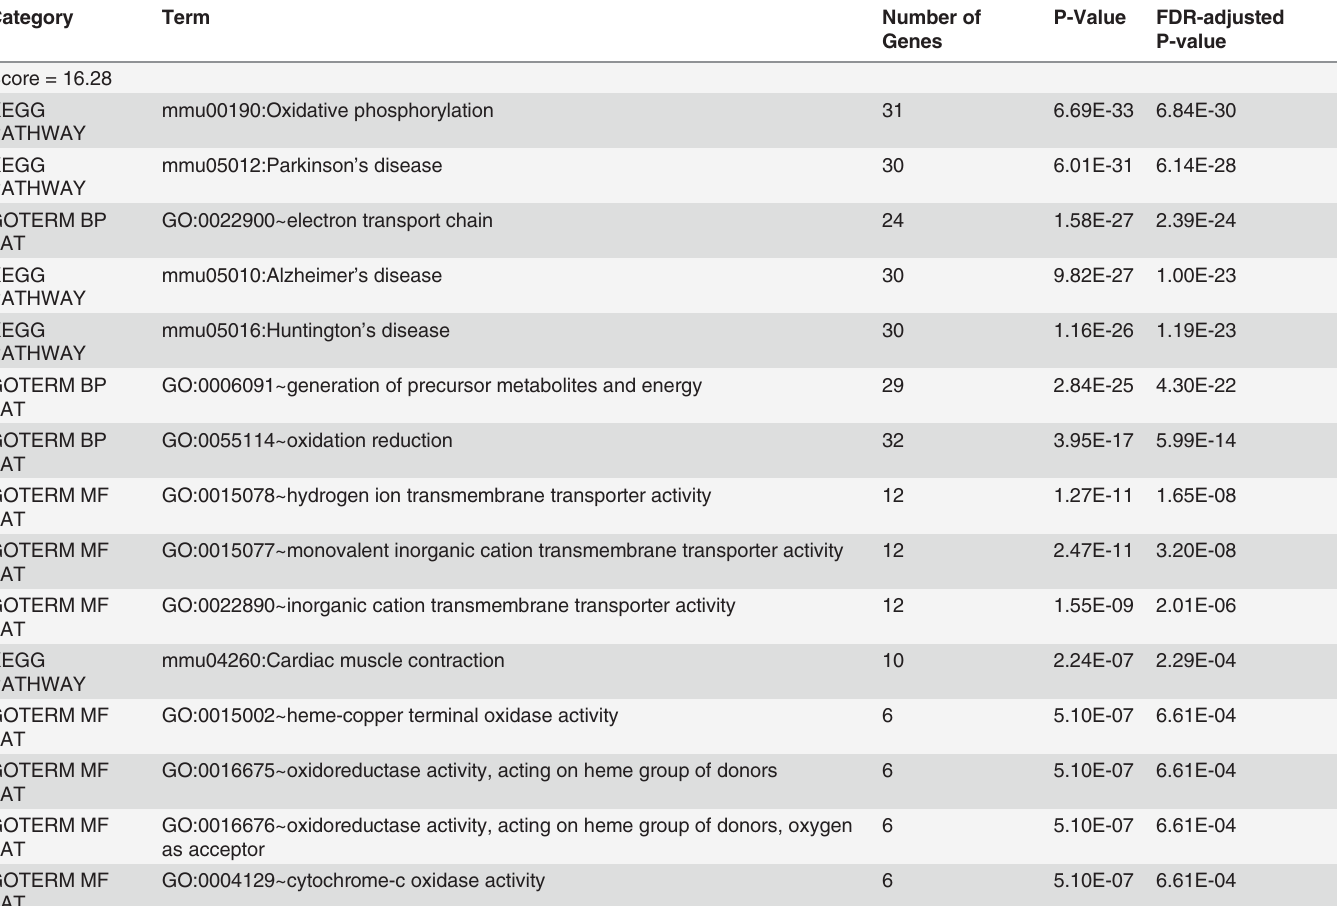
Table 4. Enriched (enrichment score > 3.0) clusters of Gene Ontology (GO) biological process (BP), molecular function (MF) Functional Annotation Tool (FAT) categories, and KEGG pathways among the genes exhibiting the pro fi le characterized by under-expressed in active wild- type vs inactive myostatin-reduced and in active myostatin-reduced vs inactive myostatin-reduced and not differentially expressed in all other contrasts.